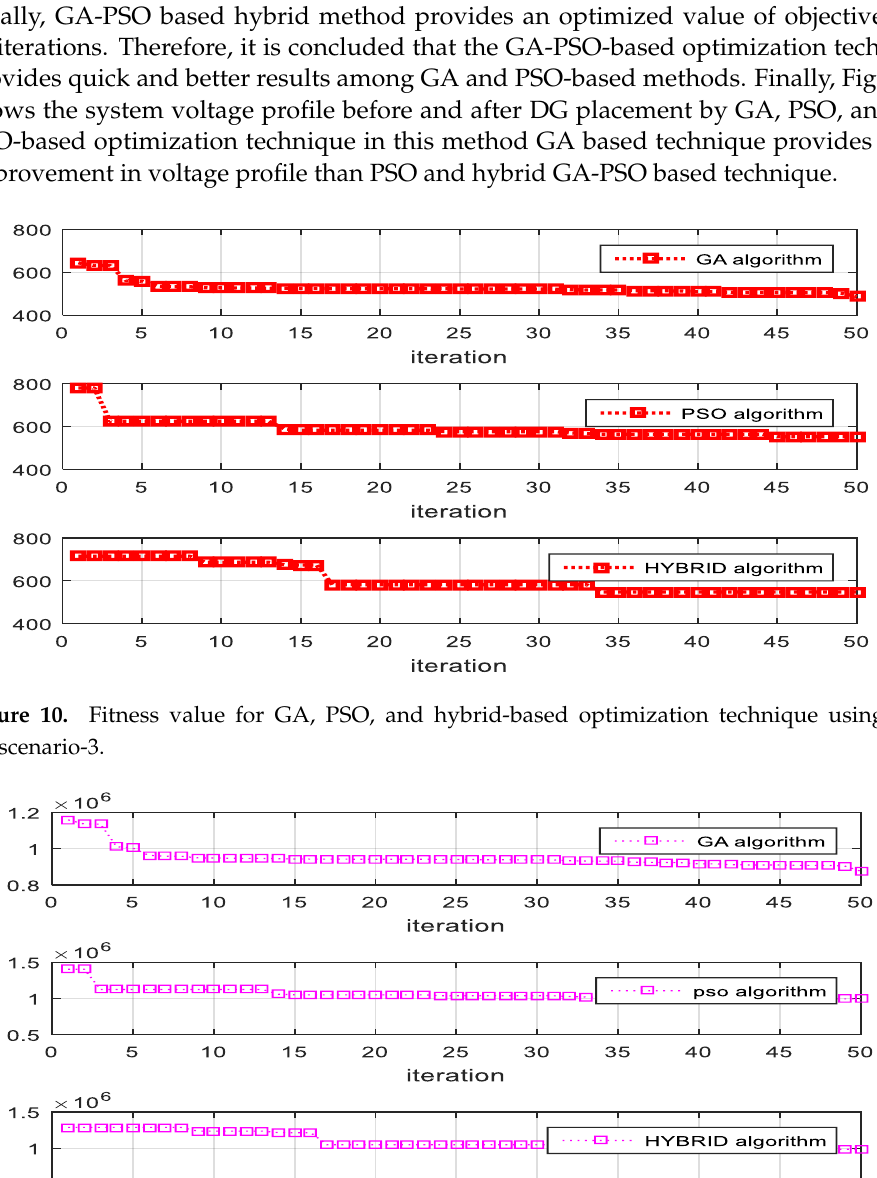
Figure 12. System voltage profile using PEM scenario-3 load flow method and GA, PSO and hybrid- based optimization technique with and without DG unit.